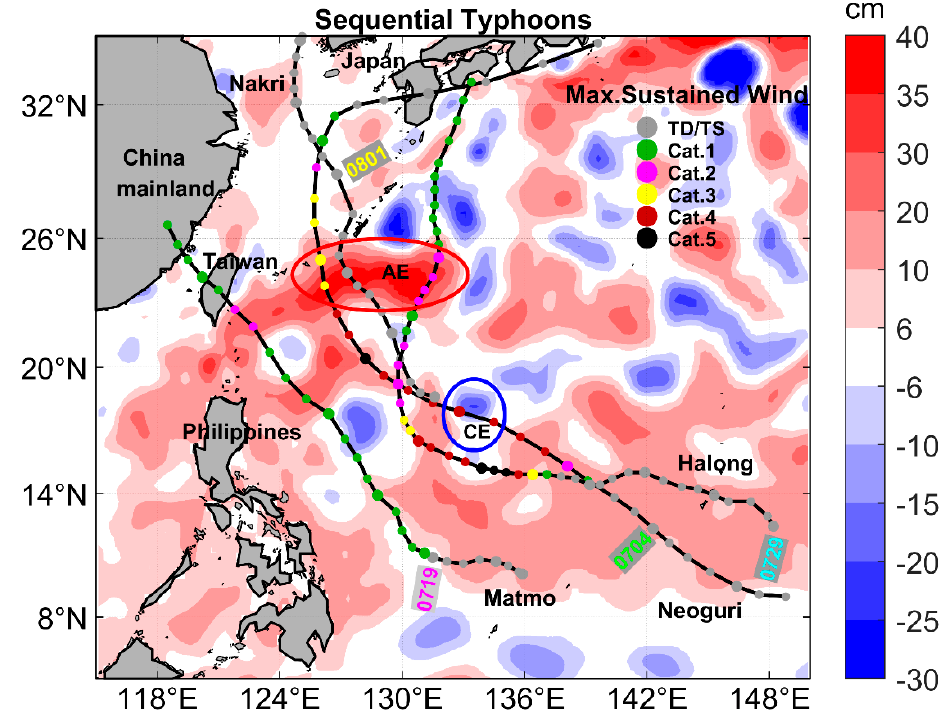
Figure 1. The tracks of four sequential TCs, Neoguri, Matmo, Nakri and Halong, in 2014. The background is the SSHA field on July 1 before the passage of the first TC